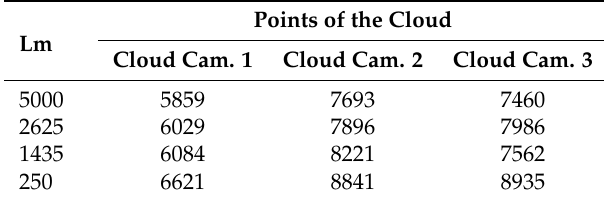
Table A3. Evaluation of the influence of the light source luminous flux.